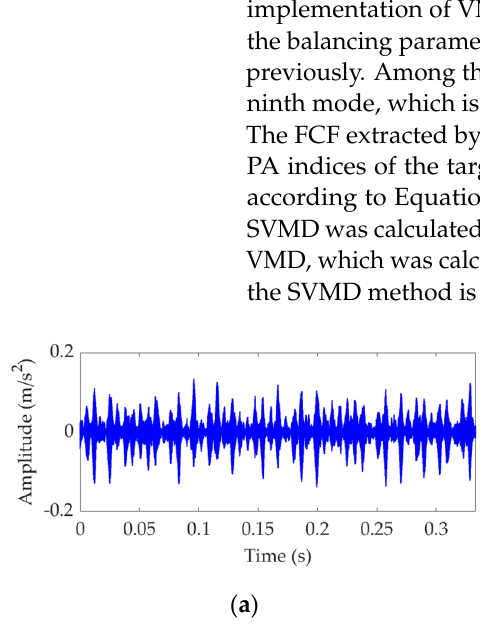
( b ) Figure 17. Vibration dataset associated with the outer race fault: ( a ) time − domain waveform and ( b ) SES. To apply the SVMD method to the dataset process of this case, the optimal value of the balancing parameter α was searched in the range 50–10,000, and then the α value in- creased from 50 to 10,000 at a step size of 50. The finally obtained relationship curves between the α value and the EP index and order number of the target mode in each step of α increase are shown in Figure 18. It can be seen that the optimal value of α is α opt = 6650 because the corresponding target mode obtained by SVMD has the global mini- mum value for the EP index, and this optimal target mode is the eighth mode among the